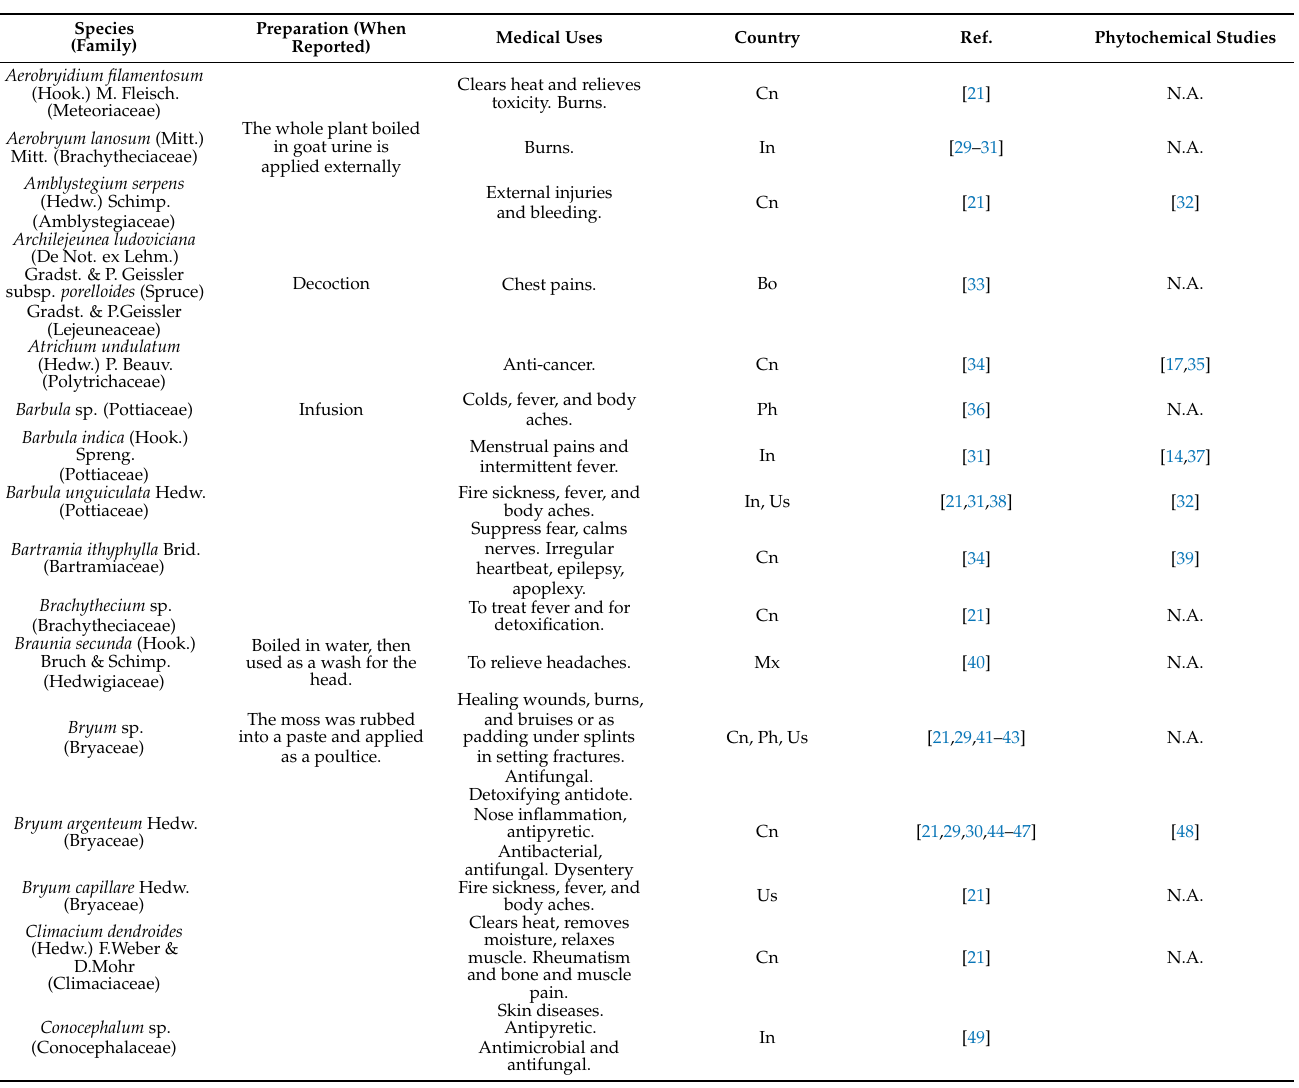
Table 1. Identified mosses and liverworts used as traditional herbal remedies. (Au =